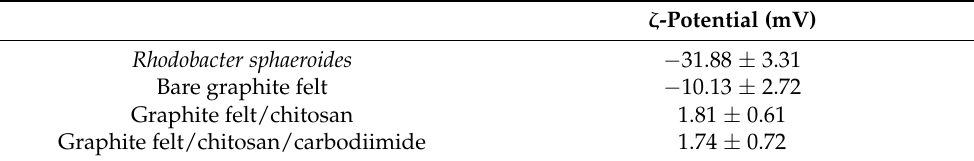
Table 1. Zeta-potential results for R. sphaeroides , bare graphite felt, chitosan-modified graphite felt, and chitosan/carbodiimide compound-modified graphite felt in 0.1 M sodium phosphate buffer (pH 7.0).